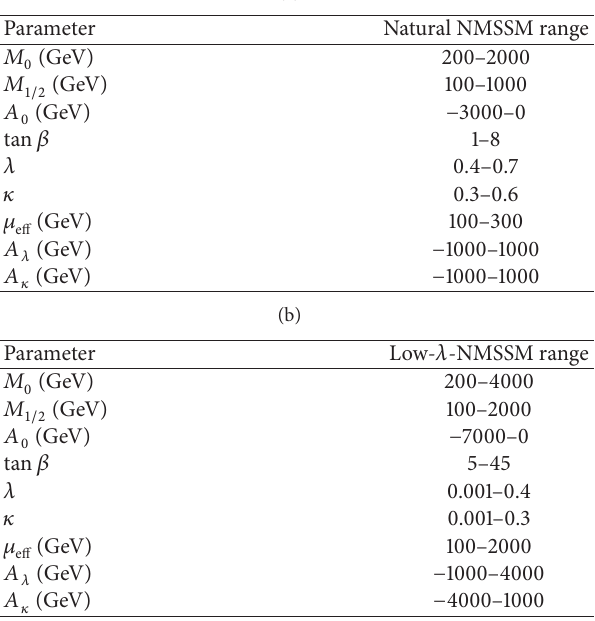
Table 1: Ranges of the NMSSM parameters scanned, with fixed 𝜙 𝜅 , scenario in the natural NMSSM and (b) the low- 𝜆 - for (a) each 𝐻 obs NMSSM